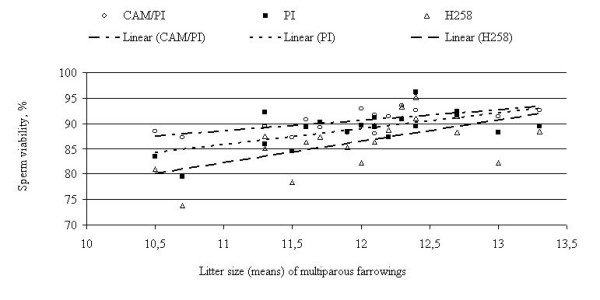
Relationship between sperm viability assessment methods and litter size of multiparous farrowings. Circle indicates microscopically assessed sperm viability results based on CAM/PI staining; Square indicates fluorometrically-assessed sperm viability results based on PI staining; Triangle indicates fluorometrically-assessed sperm viability results based on H258 staining. The lines show the trend in the data.